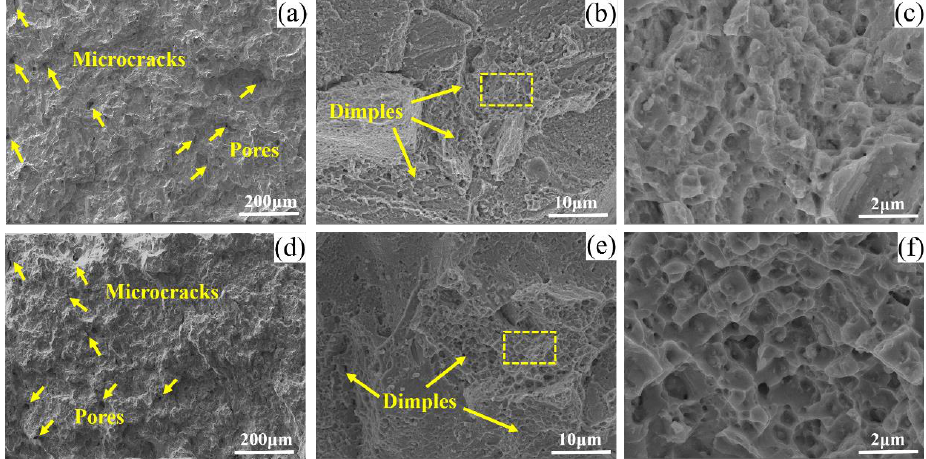
Figure 13. Room-temperature fractures of ( a – c ) 13Co and ( d – f )